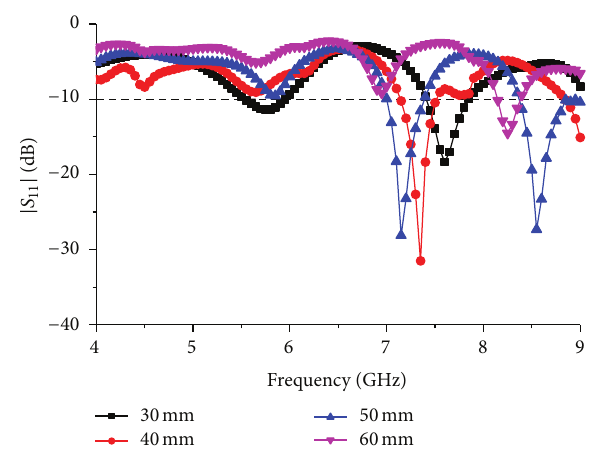
Figure 7: Response to the parametric change in the ground plane width “ 𝑝 ”.